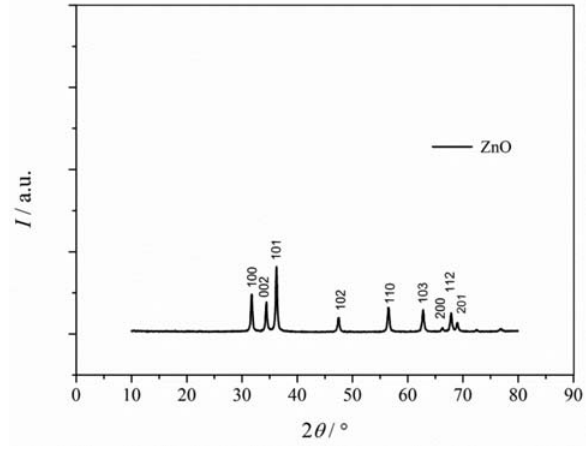
Figure 1. XRD pattern of the prepared ZnO nanoparticles